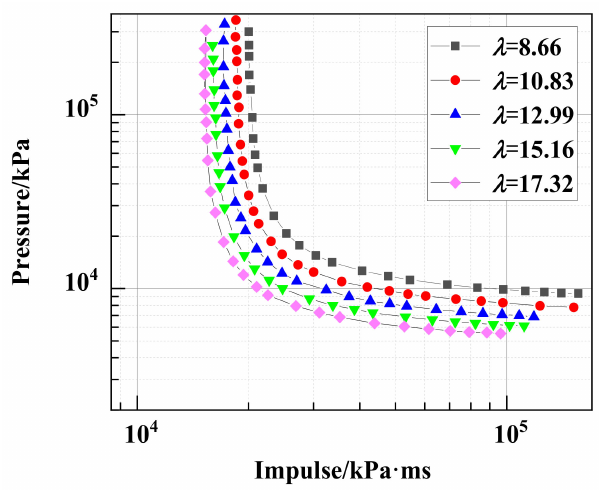
Figure 13. P-I curves of shear response with different slenderness ratios. Table 8. Effect of slenderness ratios on